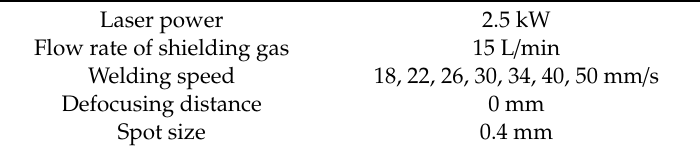
Table 2. Laser welding parameters used in the experiment.